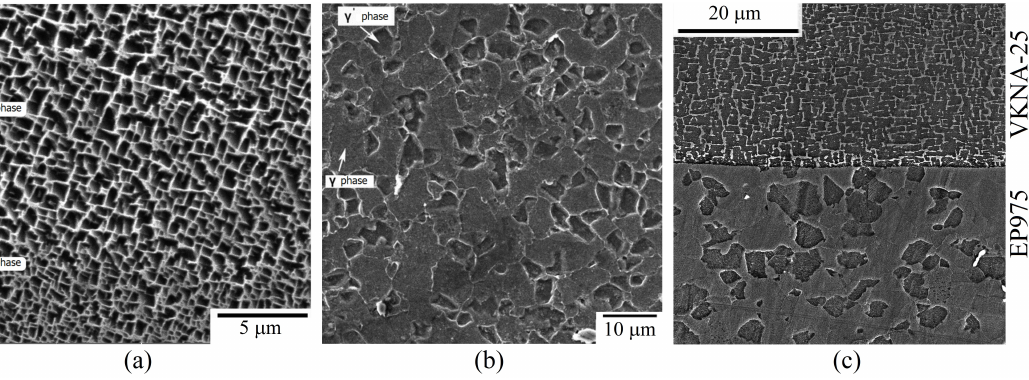
Figure 1. Microstructure of the intermetallic alloys VKNA-25 ( a ) and EP975 ( b ). Both alloys are the mixture of the Ni 3 Al intermetallic compound ( γ ’ phase), which appears in dark color, and the solid solution of alloying elements in Ni 3 Al ( γ phase) has a light color. ( c ) Microstructure of the joint of EP975 (bottom) and VKNA-25 (top)